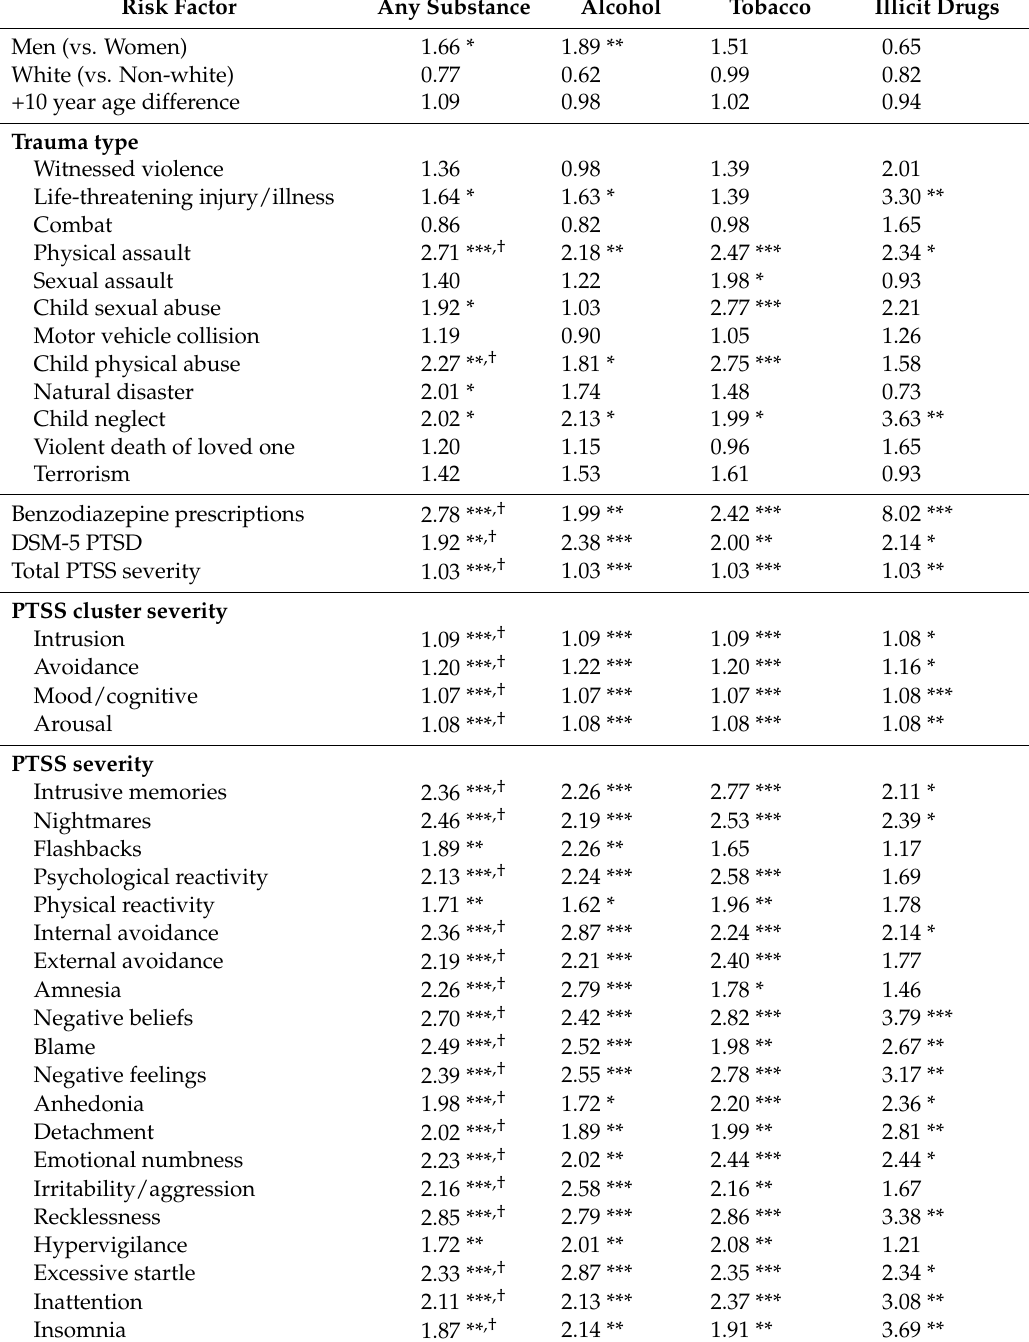
Table 2. Adjusted odds ratios for associations between explanatory variables and substance-related problems (adjusted for gender, race, and age). Risk Factor Any Substance Alcohol Tobacco Illicit Drugs Men (vs. Women) White (vs.